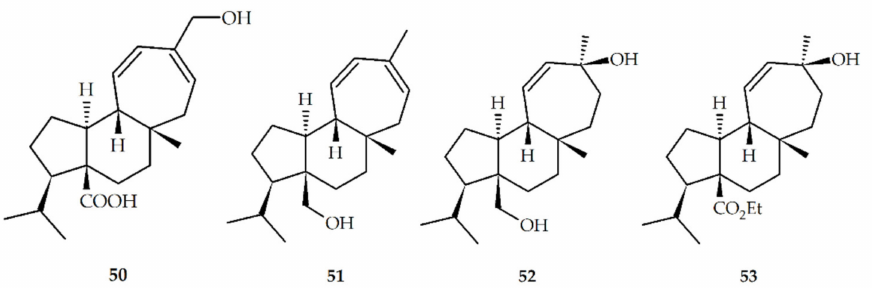
Figure 4. Synthetic mulinanes diterpenoids.